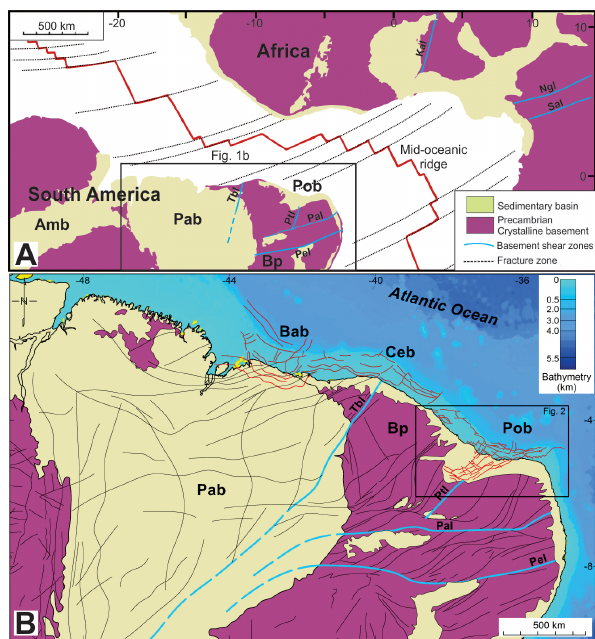
Figure 1. (a) Schematic reconstruction of northeastern Brazil and western Africa at chron C34 (84Ma) showing the main prerift pierc- ing point and sedimentary basins (Amb – Amazon; Pab – Parnaíba; Pob – Potiguar) in both margins (adapted from Moulin, 2010). Bp – Borborema Province. Precambrian lineaments: Tbl – Transbrasil- iano; Ptl – Portalegre; Pal – Patos; Pel – Pernambuco; Kal – Kandi; Ngl – Ngaoundere; Sal – Sanaga. (b) Detailed view of the equatorial margin showing the tectonic setting of the Potiguar Basin. The red faults along the margin were formed during the breakup of Pangea; the black traces in the Parnaíba Basin area represent major Precam- brian basement terrain boundaries, basement foliations, and shear zones. Basins: Bab – Barreirinhas; Ceb – Ceará; Pob – Potiguar; Pab –